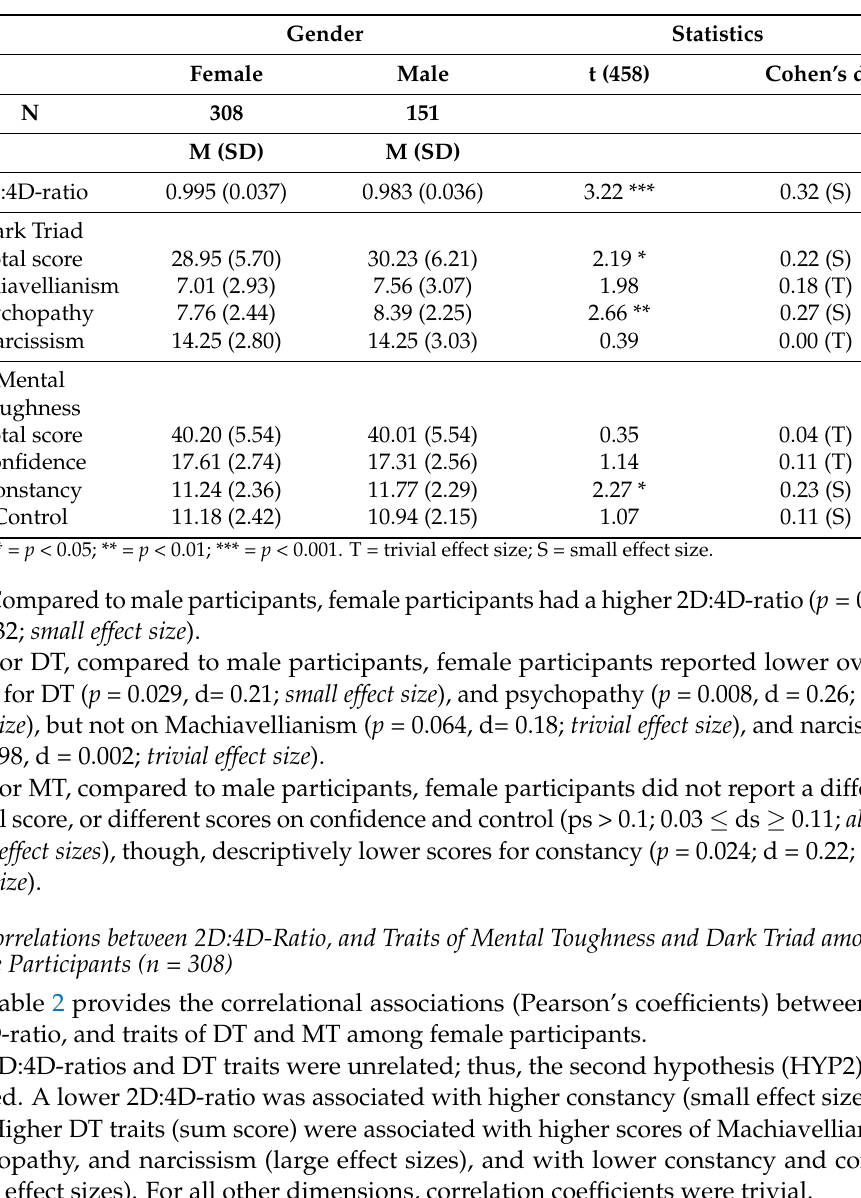
Table 1. Descriptive and inferential statistical overview of 2D:4D-ratios, dimensions of mental toughness (MT), and dark triad (DT) between female and male